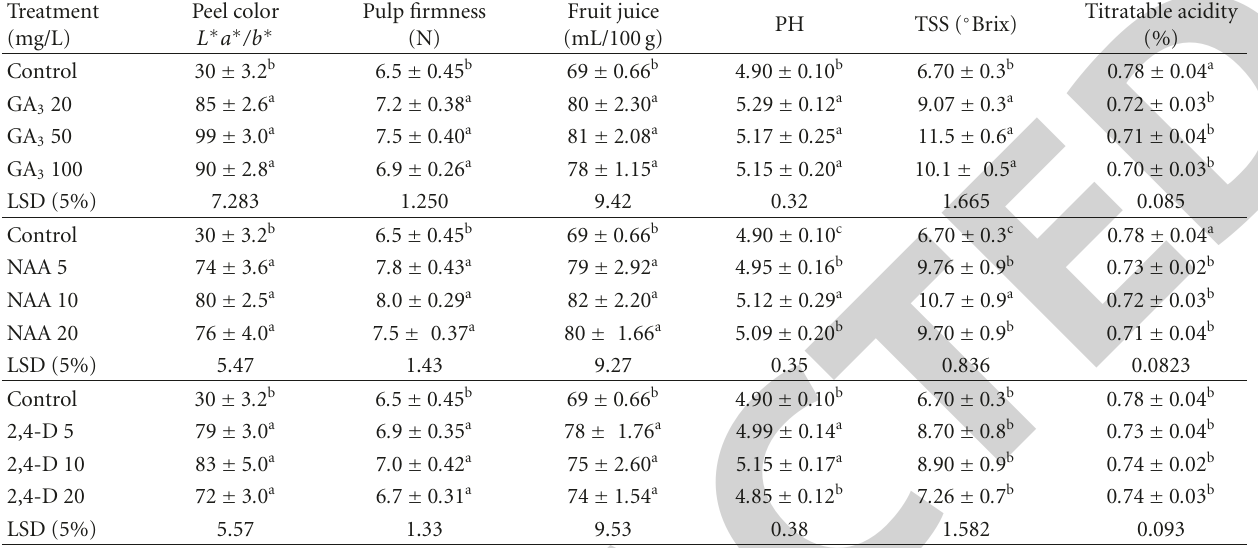
Table 1: E ff ect of GA 3 , NAA and 2,4-D treatments on physicochemical properties of wax apple fruits. Treatment